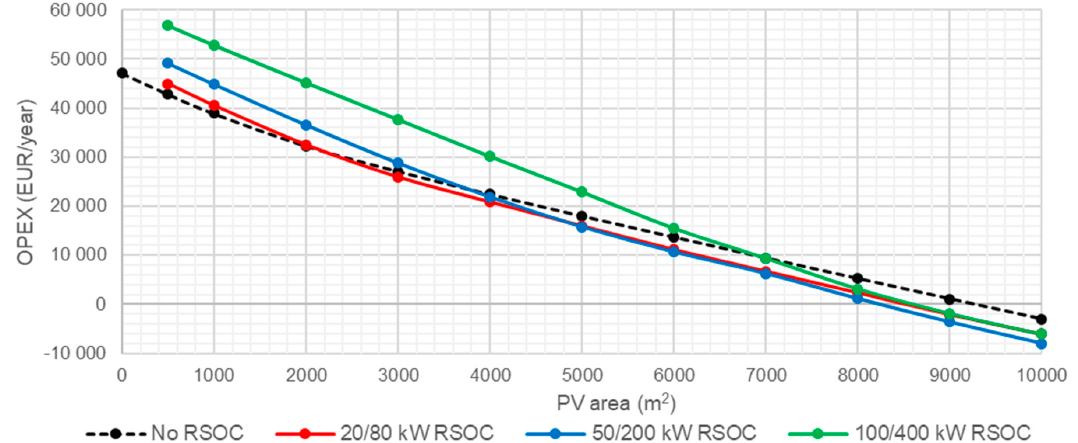
Figure 7. Optimal annual operating expense (OPEX) (for the optimal hydrogen storage size) as a function of installed solar photovoltaic (PV) panel area for the three RSOCHS systems and the reference system. Buildings 2020 , 10 , x FOR PEER REVIEW